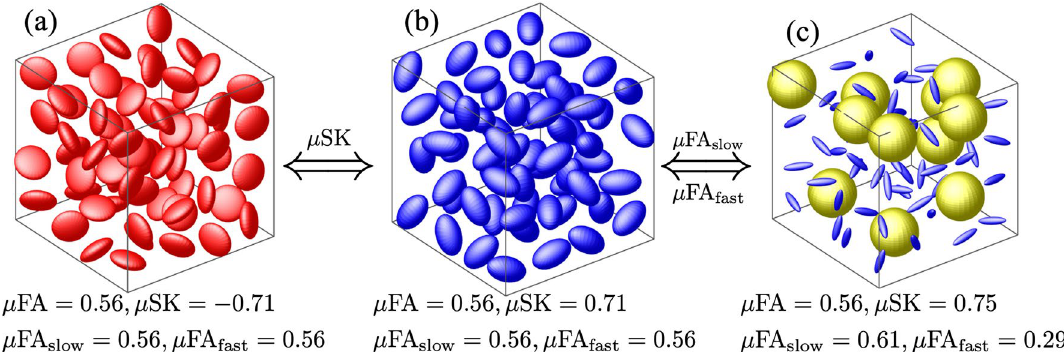
Figure 1. Comparison of three synthetic diffusion tensor distributions (DTDs). The yellow, red and blue- colored spheres with isotropic, oblate and prolate spherical shapes represent different tensors of different eigenvalues and